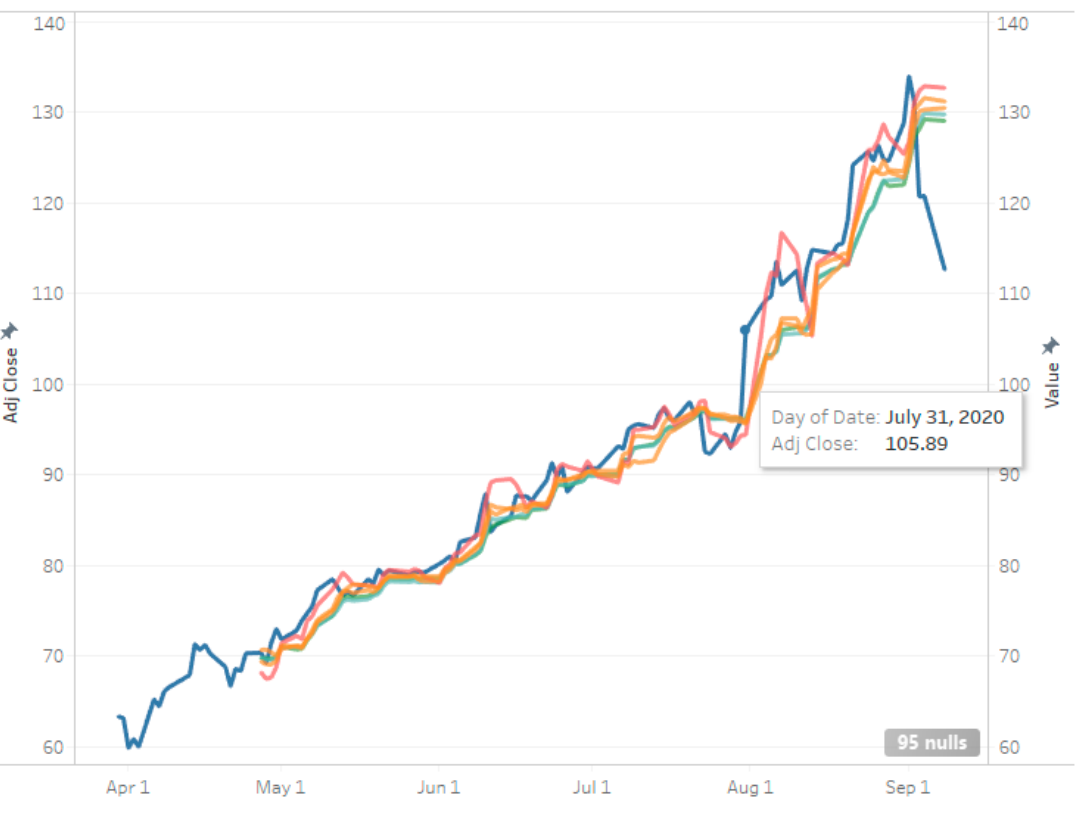
Figure 13. All SA-LSTM Model Comparison—AAPL. Visually, it seems that the LSTM models under-predict the stock prices regardless of method used. Hence, the RMSE values are largely contributed to by negative errors. It may be possible to improve the model by increasing the weights for positive